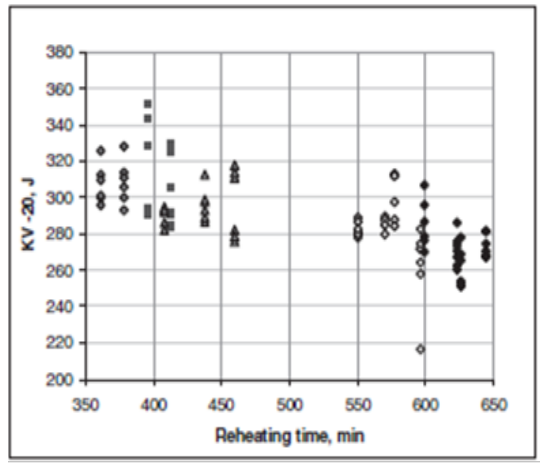
Figure 12. KV at −20 °C Joules as function of time at 1170 °C (reproduced from [22], with permission Figure 12. KV at − 20 ◦ C Joules as function of time at 1170 ◦ C (reproduced from [22], with permission from The Minerals, Metals &Materials Society, 2015). from The Minerals, Metals &Materials Society,